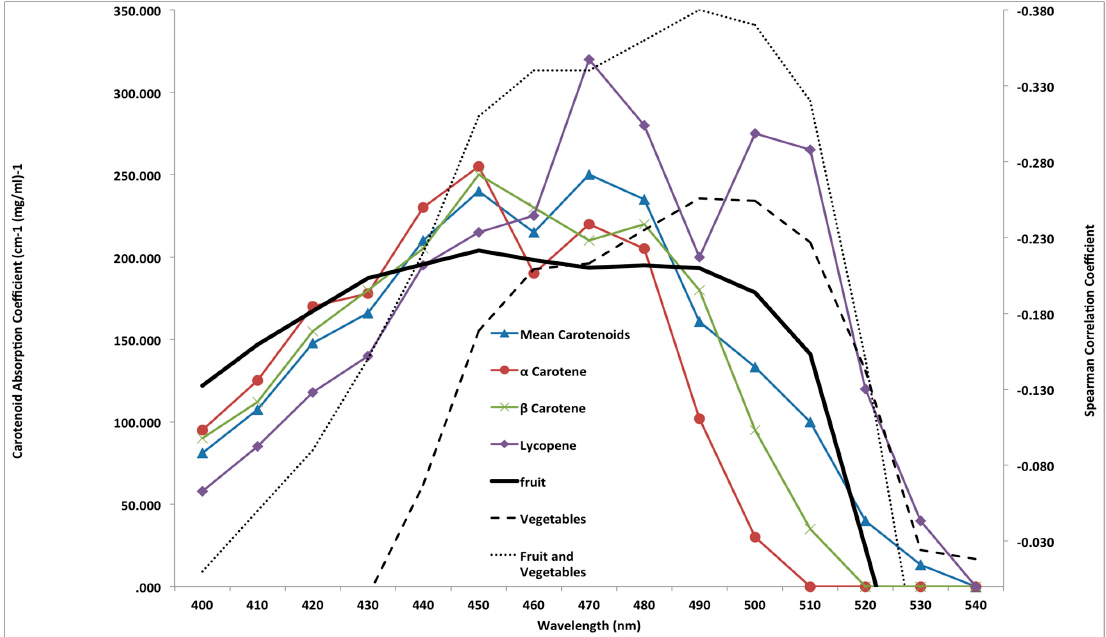
Figure 1. Spearman correlation coefficients between skin reflectance values and fruit, vegetable and combined fruit and vegetable consumption (servings per day) plotted with absorption spectra of common carotenoids.